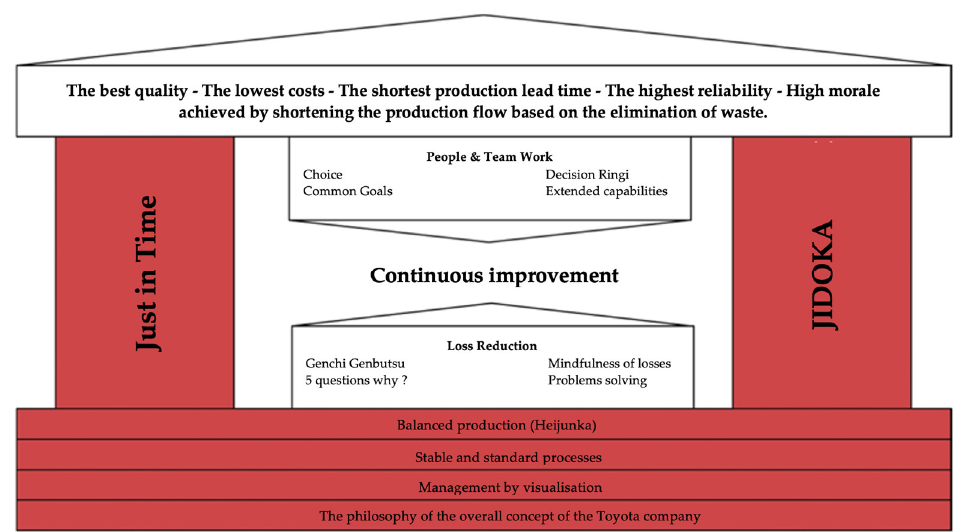
Figure 3. Two-pillar scheme of the Toyota Corporation’s production system. Source: Authors’ compilation according to [24].